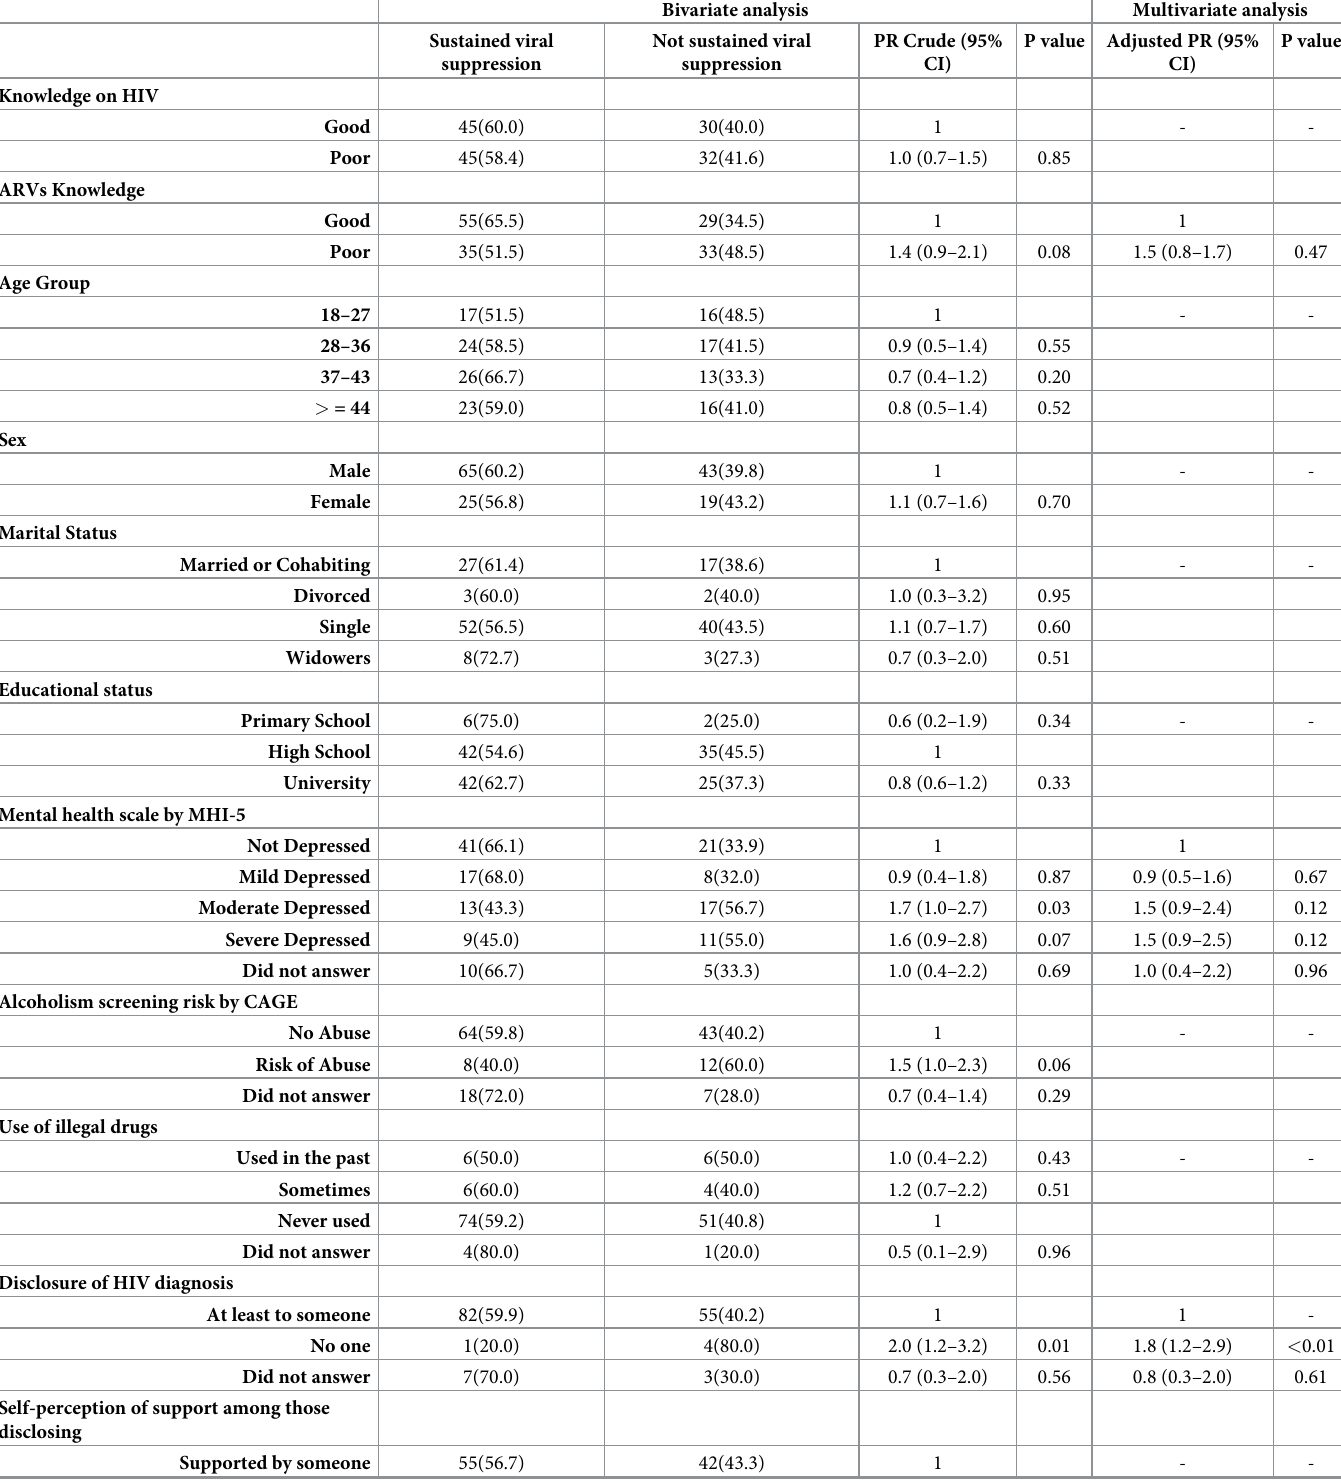
Table 4. Bivariate and multivariate analysis of determinants of not achieving sustained viral suppression among people living with HIV in a referral center in Lima, Peru, 2016–2017 (N =